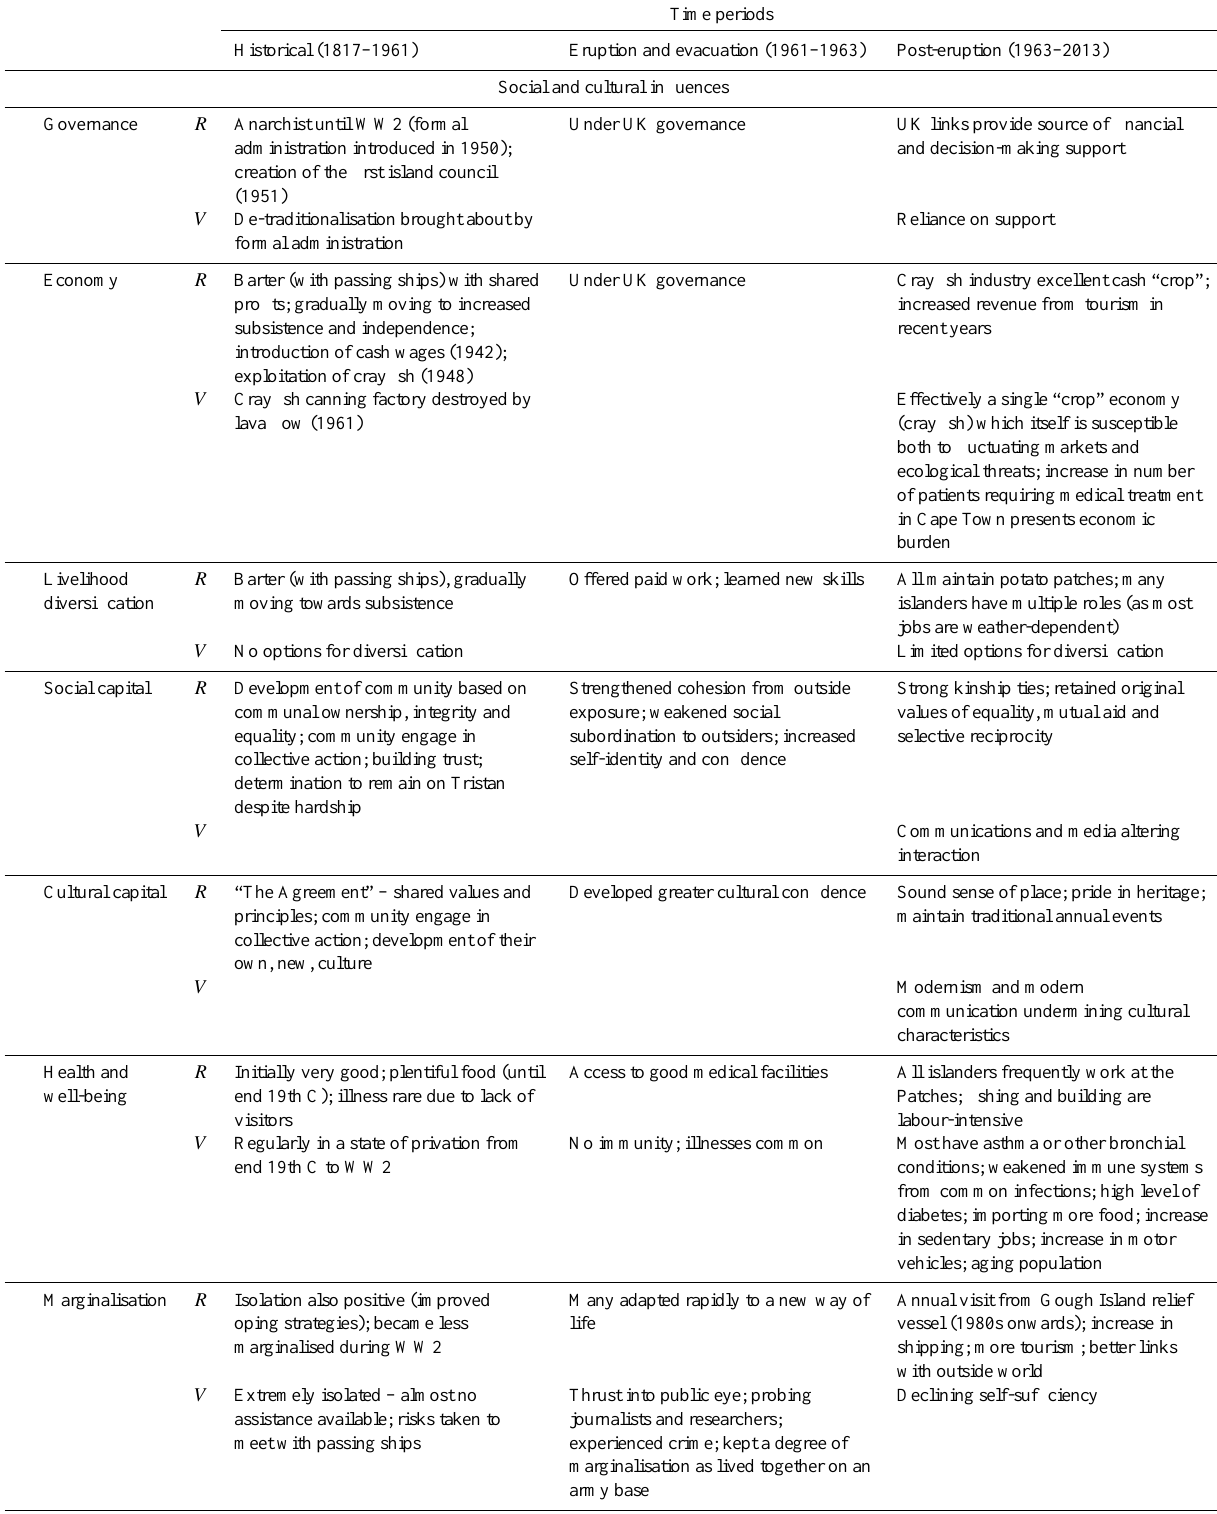
Table 2. Economic, social and cultural influences on vulnerability ( V ) and resilience ( R ), and their dynamics since